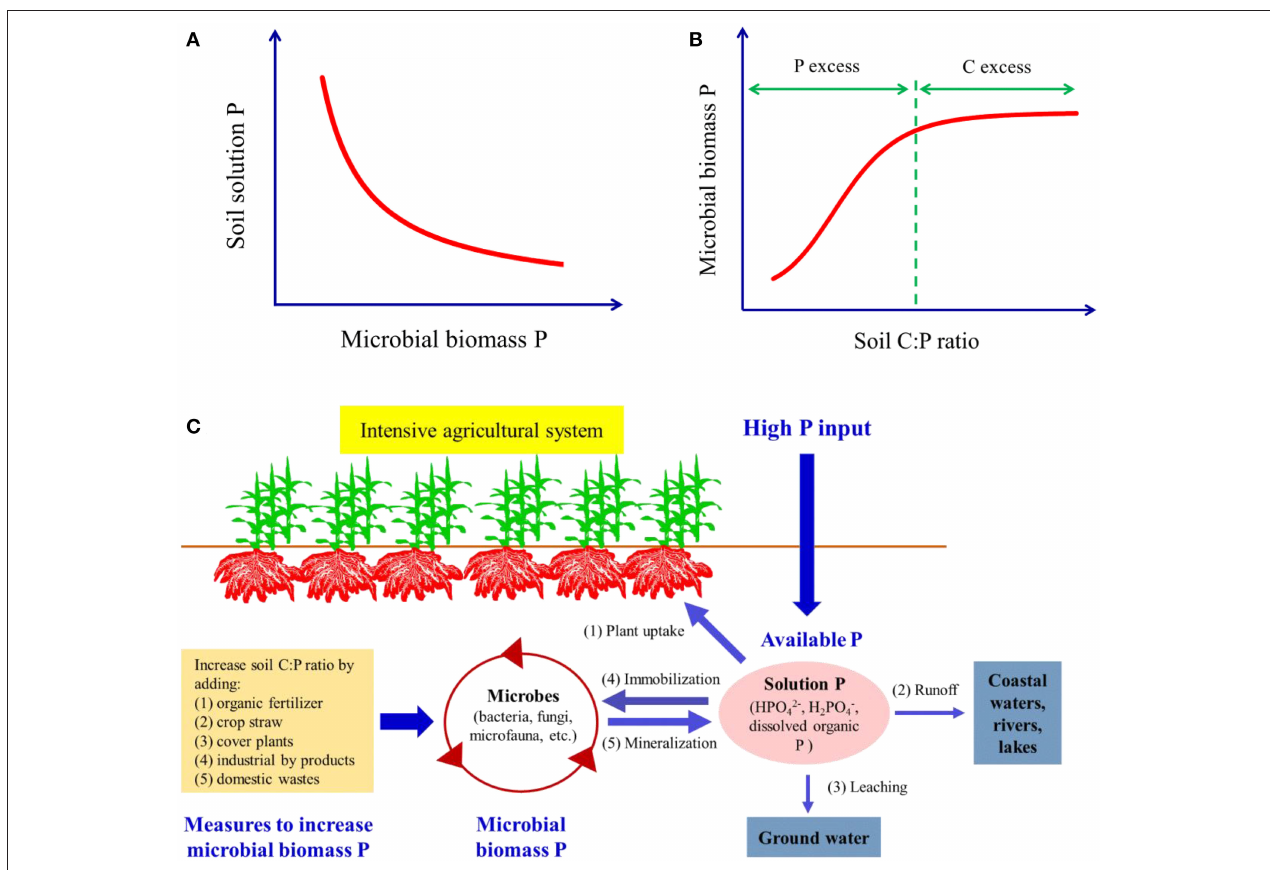
FIGURE 1 | (A) The relationship between microbial biomass P and soil solution P; (B) the relationship between soil C:P ratio and microbial biomass P; (C) the measures to increase microbial biomass P by increasing soil C:P ratio to reduce P